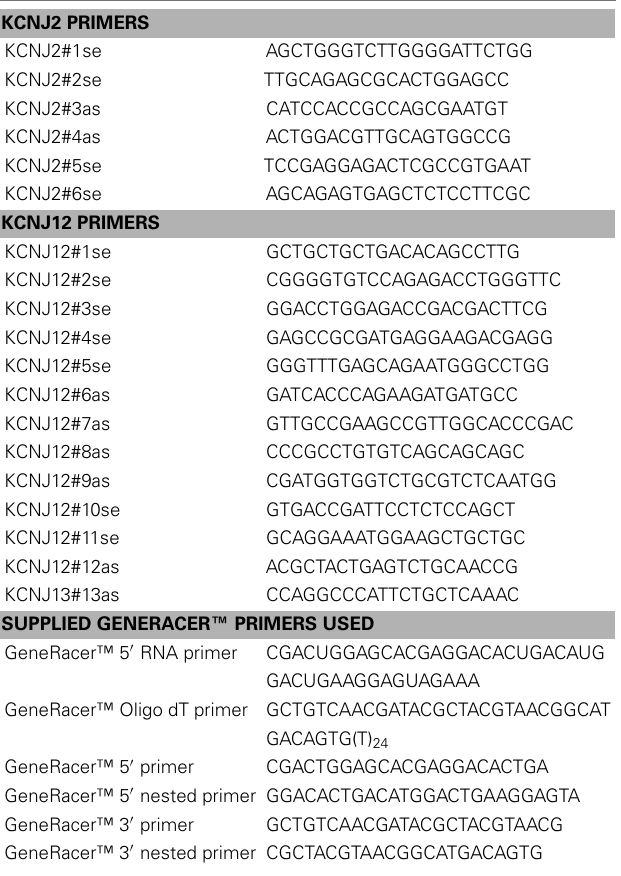
Table 1 | Sequences of primers used in this study, sequences are given in 5 (cid:2) –3 (cid:2)